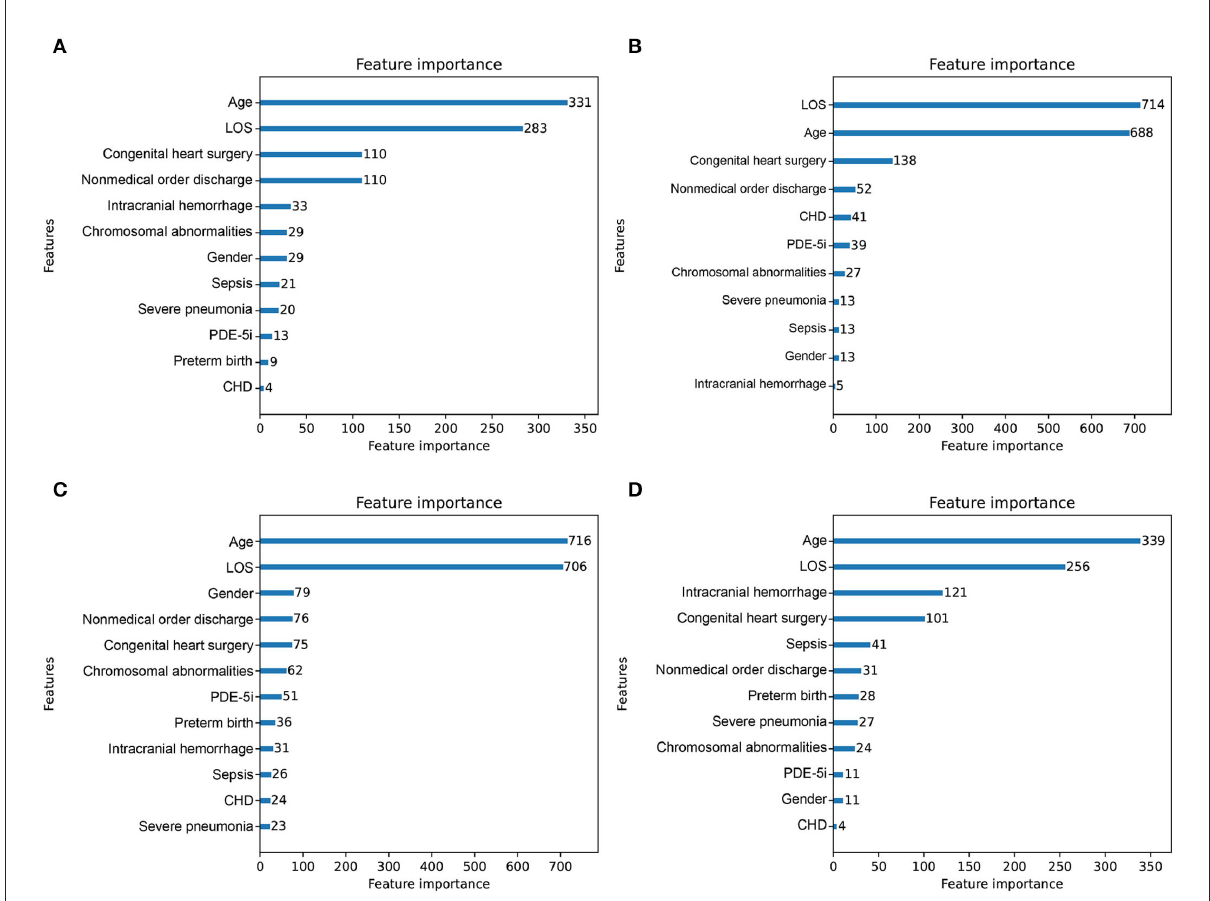
FIGURE4 Importance score ranking of features in 4 readmission-predicting algorithms. (A) CatBoost. (B) Light Gradient Boosting Machine. (C) eXtreme gradient boosting. (D) Random